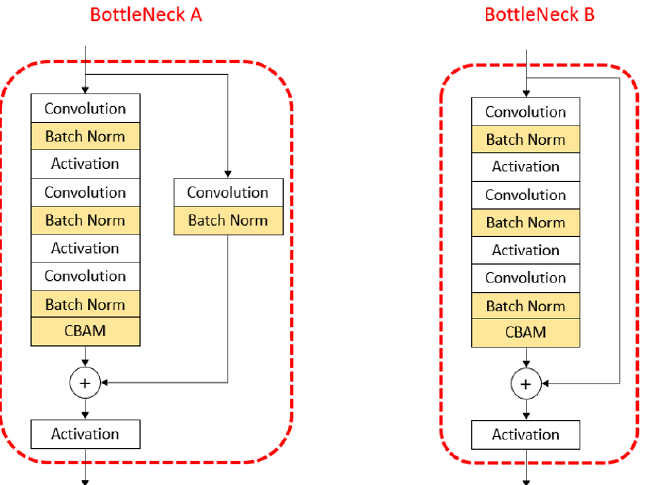
Figure 10. Structures of BottleNeck A and BottleNeck B in Figure 9’s construction, embedded with CBAM modules